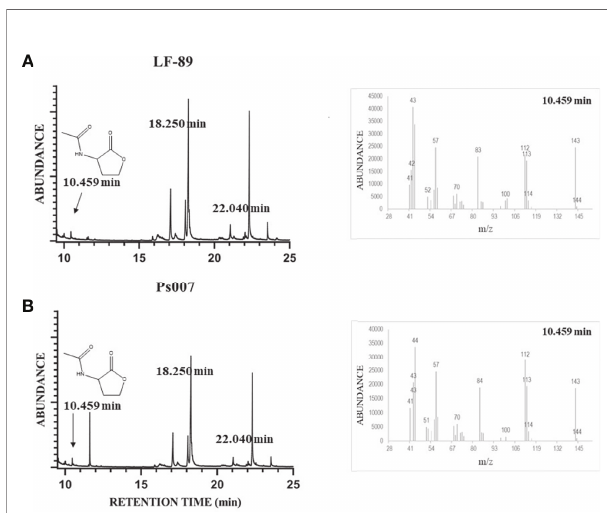
FIGURE 4 | Identi fi cation of AHLs molecules in P. salmonis culture organic extract by GC/MS analysis. LF-89 T (A) and Ps007 (B) spectrum. Mass spectrum at t=10.459 min was included for both samples. The standard solutions of C4-HSL, C6-HSL, C8-HSL, and C12-HSL were prepared in GC- ECD/FID-grade acetone. MS conditions were as follows: electron ionization source set to 70 eV, MS Quad 150°C, MS Source 230°C. The mass spectrometer was run in full-scan mode (m/z 15 – 350) and Selected Ion Monitoring (SIM) at m/z 143.The sensor and GC/MS results are representative of three independent